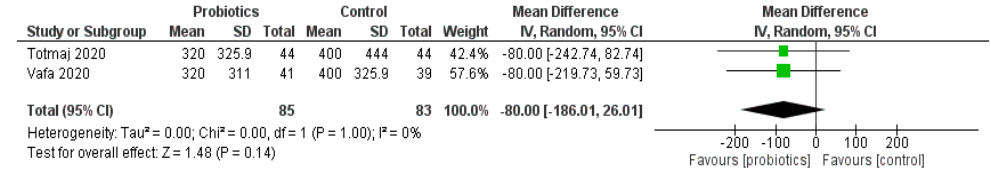
Figure 9. Meta-analysis of edema volume.